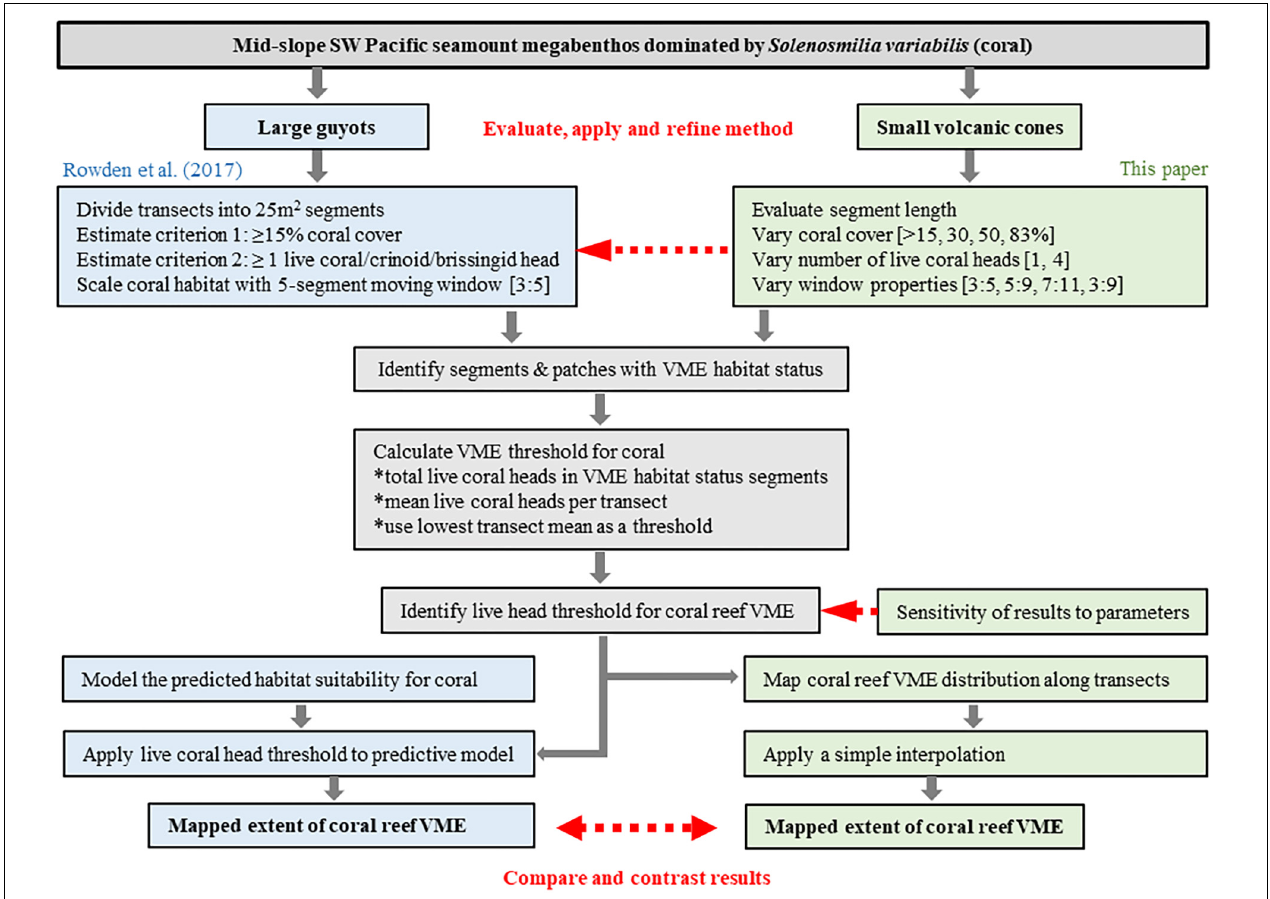
FIGURE 3 | Schematic showing overview of process to evaluate and develop the method of Rowden et al. (2017) to spatially define coral reef VME habitat using image-derived data. The red arrows identify key phases of the process: (1) evaluate, apply and refine the method; (2) identify sensitivities to changes in methodology; (3) interpret the output for Tasmanian